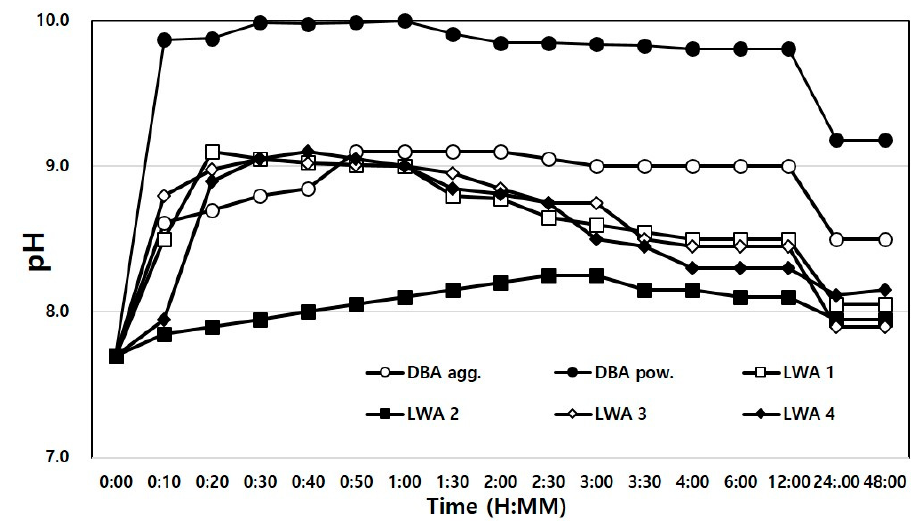
Figure 15. Time-dependent pH variance in distilled water.